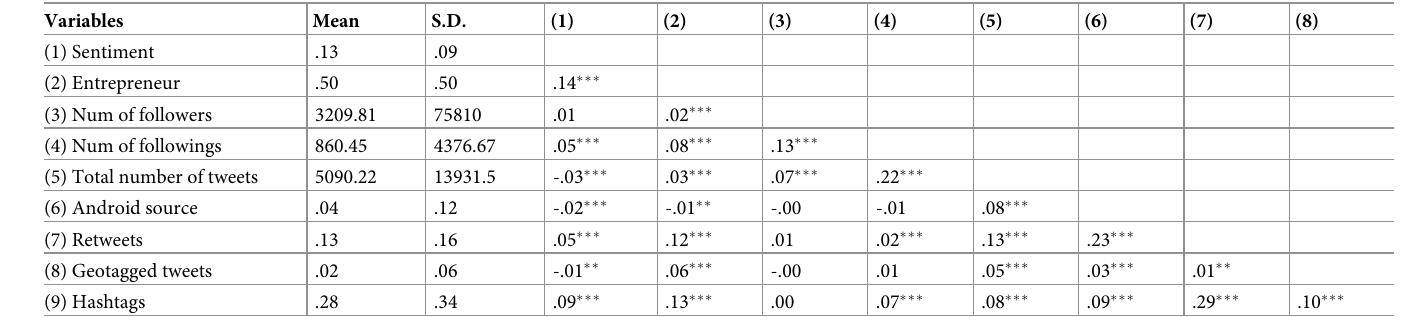
Table 4. Descriptive statistics and correlations for worldwide data (N = 49,146).